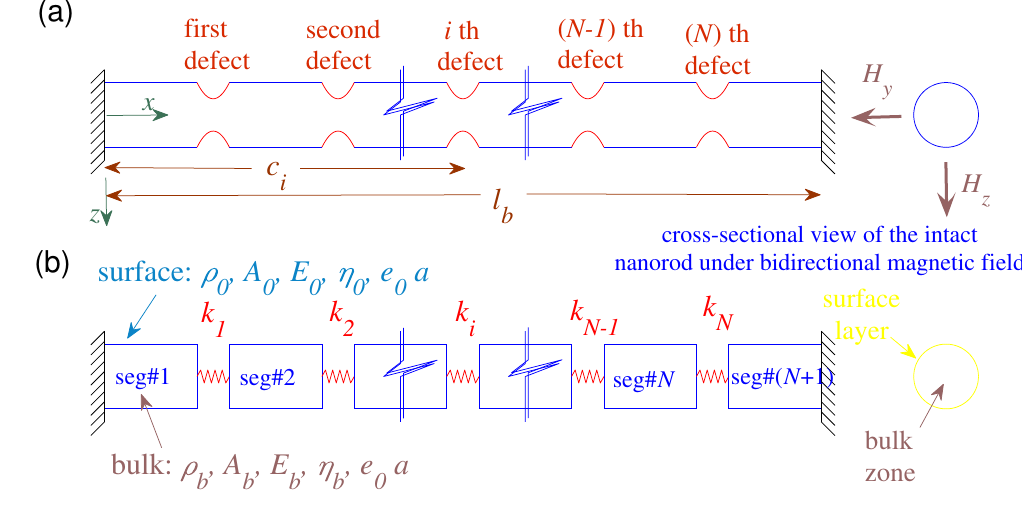
Figure 1. ( a ) A nanorod with multiple defects acted upon by bilateral magnetic fields with fixed–fixed ends. ( b ) Schematically represented continuum-based defected